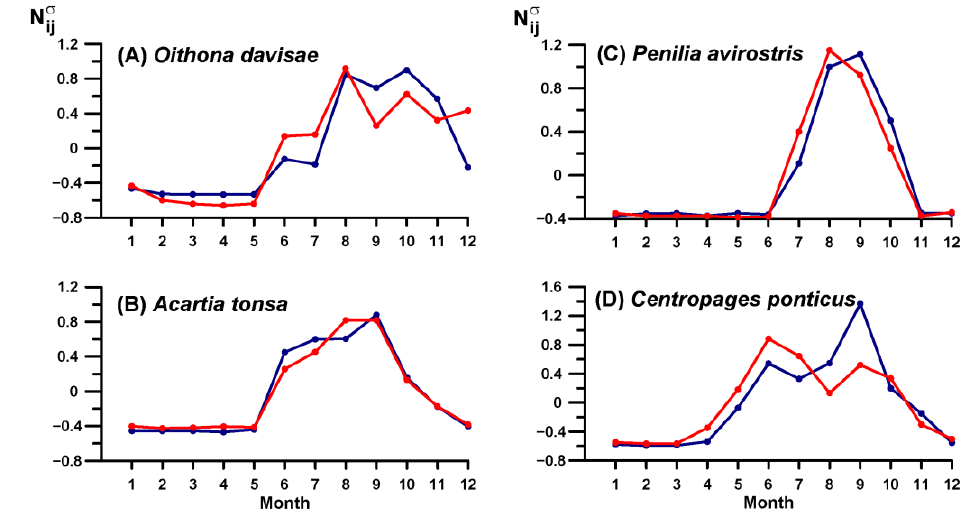
Figure 3. The patterns of seasonal dynamics of warm-water crustaceans in Sevastopol Bay at station 1 (blue) and station 2 (red) presented as normalized average monthly values (see details of the method in Section 2.4): ( A )— Oithona davisae ; ( B )— Acartia tonsa ; ( C )— Centropages ponticus ; ( D )— Penilia avirostris